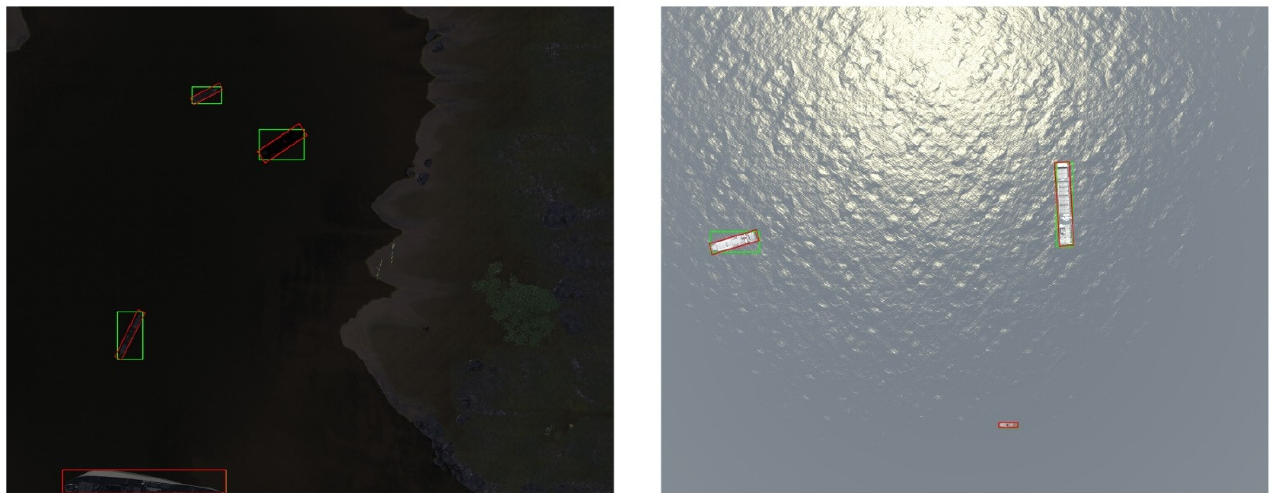
Figure 3. Example of bounding box labeling, where red indicates rotated bounding boxes, and green indicates horizontal bounding box.